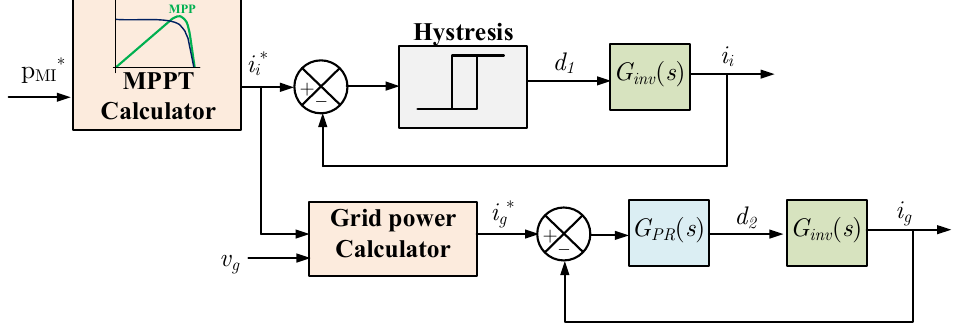
Figure 10. MCI controller during DC/AC inversion from PV modules to grid.